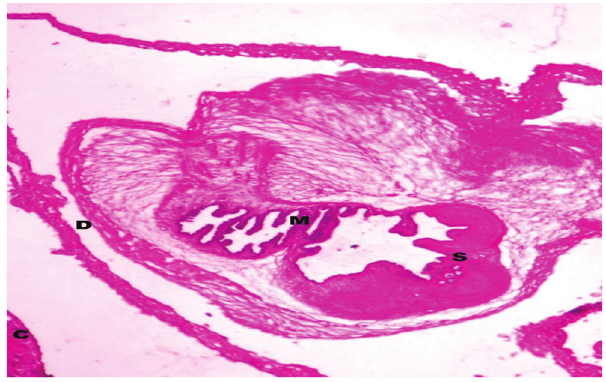
Figure 1: Swelling near the medial canthus of left eye.